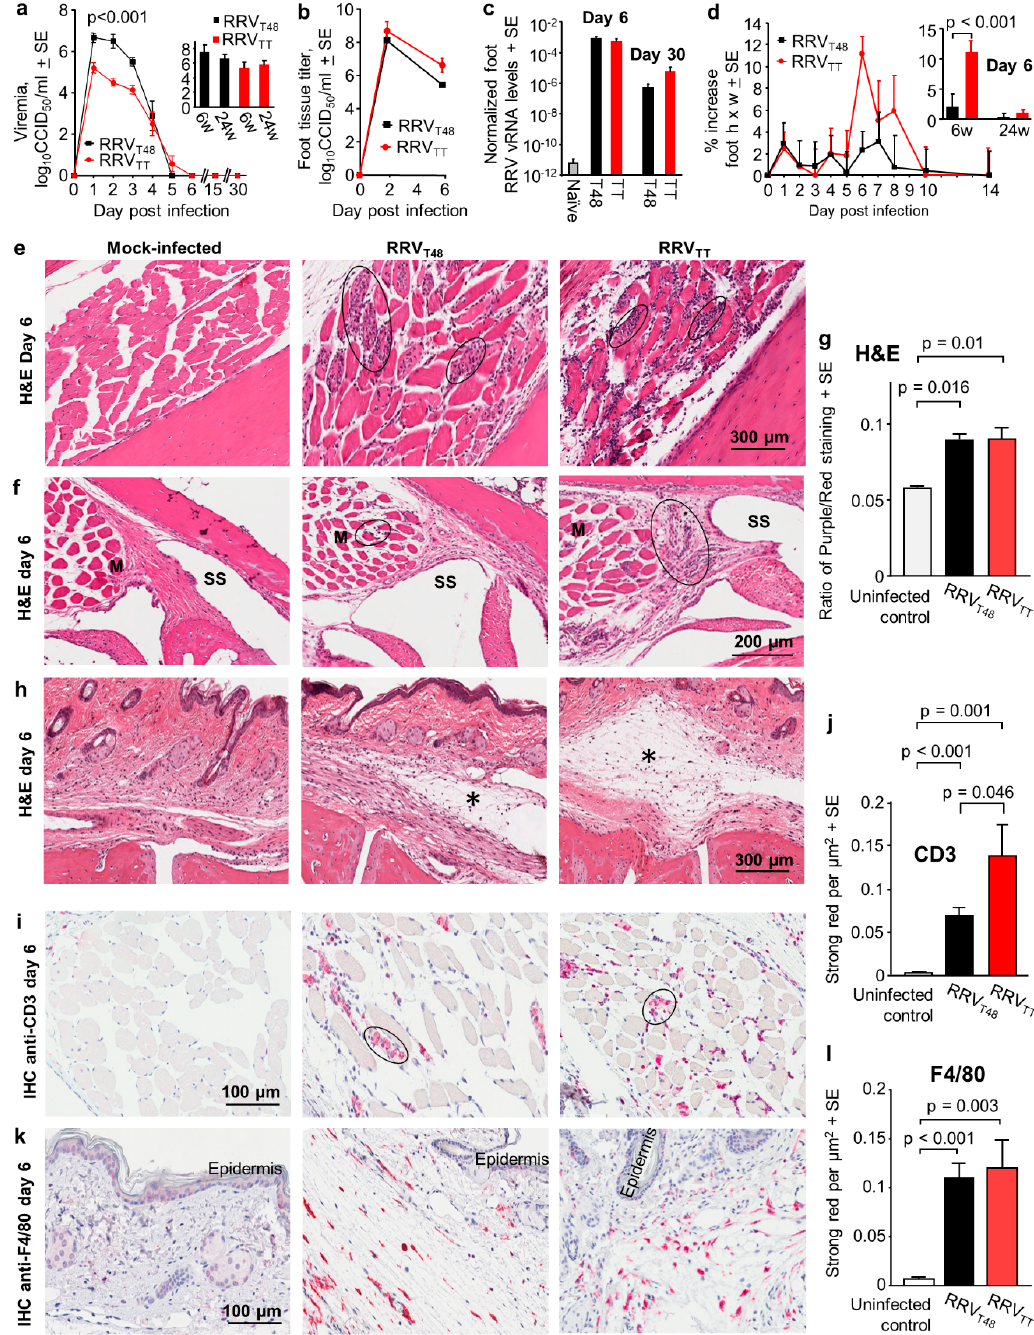
Figure 1. Ross River viruses (RRVs) RRV TT and RRV T48 arthritis in adult wild-type mice. ( a ) Viremia in adult C57BL/6J female mice (6- and 24-weeks-old) infected with 4 log 10 CCID 50 of RRV TT or RRV T48 . RRV T48 viremia was significantly higher on days 1, 2 and 3 ( p < 0.001); statistics by Kolmogorov–Smirnov tests (n = 6–12 mice per time point and data were derived from 3 independent experiments). Bar graph insert shows mean peak viremias for mice infected at 6 or 24 weeks of age; ( b ) Viral titers in feet of C57BL/6J mice infected as in (a) (n = 6 feet from 3 mice per time point); ( c ) Quantitative RT-PCR of feet from RRV infected mice (taken days 6 and 30 post-infection) using RRV NS3 primers normalized to RPL13a (n = 3 feet from 3 mice per group). Naïve represents uninfected mice; ( d ) Percentage increase in foot height x width (relative to day 0) for 6-week-old mice infected as in (a), with n = 12 feet from 6 mice per group per time point. Inserted bar graph shows the mean peak foot